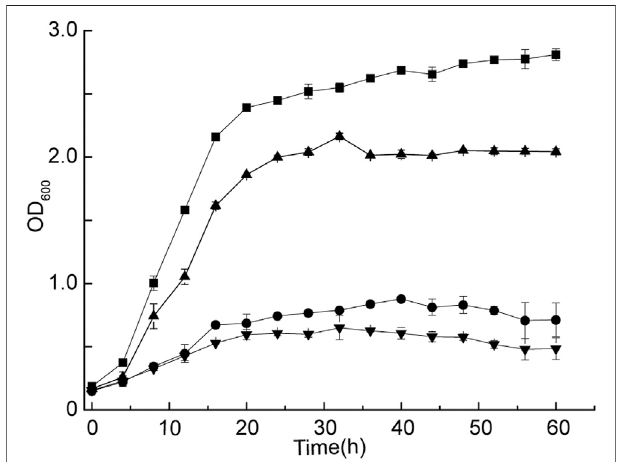
FIGURE 2 | Growth curve of G. oxydans with different D-sorbitol concentrations. Square: Growth curve of G. oxydans at 30 ° C in 50 g/L of D-sorbitol medium. Circle: Growth curve of G. oxydans at 30 ° C in 300 g/L of D-sorbitol medium. Up-triangle: Growth curve of G. oxydans at 35 ° C in 50 g/L of D-sorbitol medium. Down-triangle: Growth curve of G. oxydans at 35 ° C in 300 g/L of D-sorbitol medium.